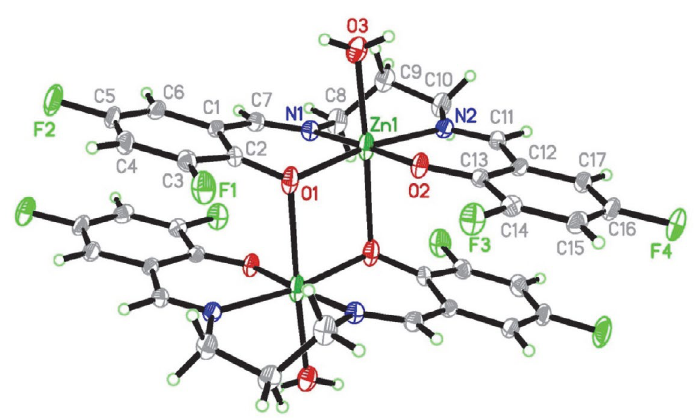
Figure 1. Molecular structure of complex 1 , with 30% thermal probability. Unlabeled atoms are at the symmetry position – x , 1 – y , 1 – z